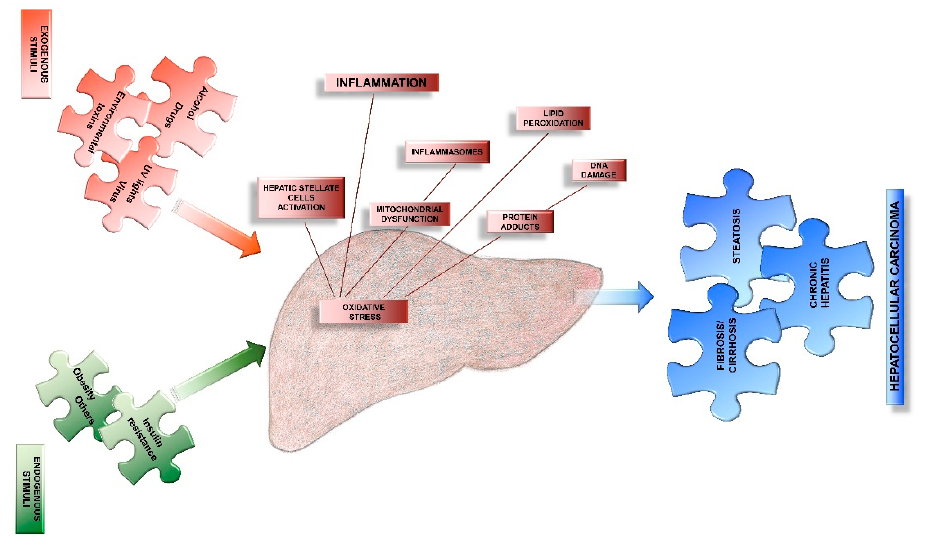
Figure 3. A schematic summary of the main determinants that are responsible to induce an increased intrahepatic oxidative stress. This summary underlines the pathways that are activated by endogenous and exogenous stimuli and the terminal changes involving hepatic parenchyma.